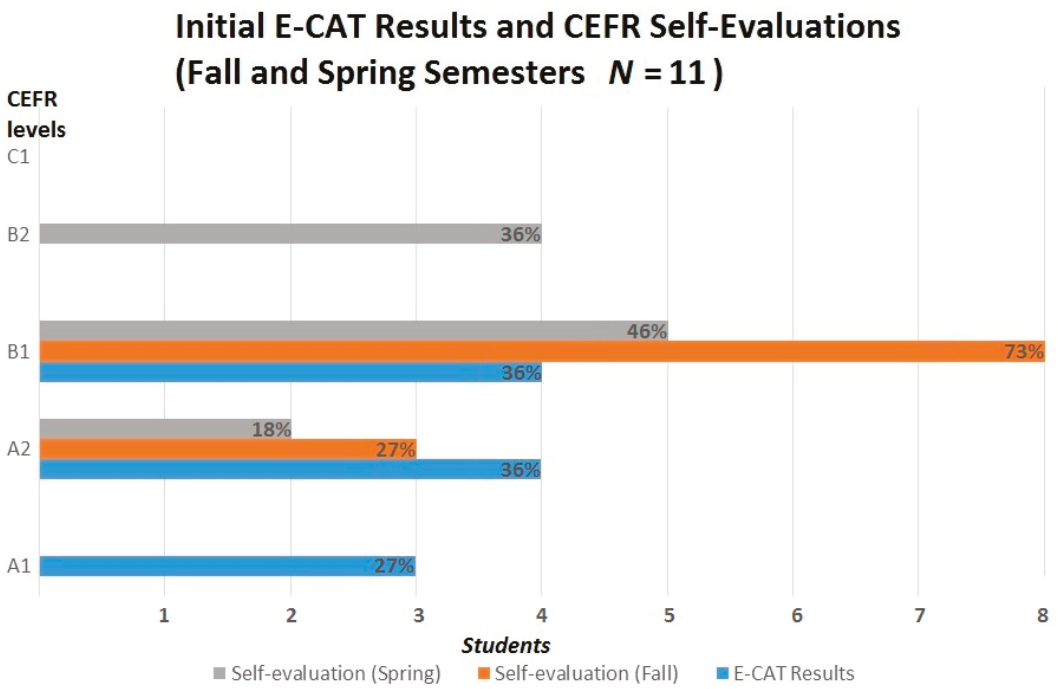
Figure 8. E-CAT 1/CEFR